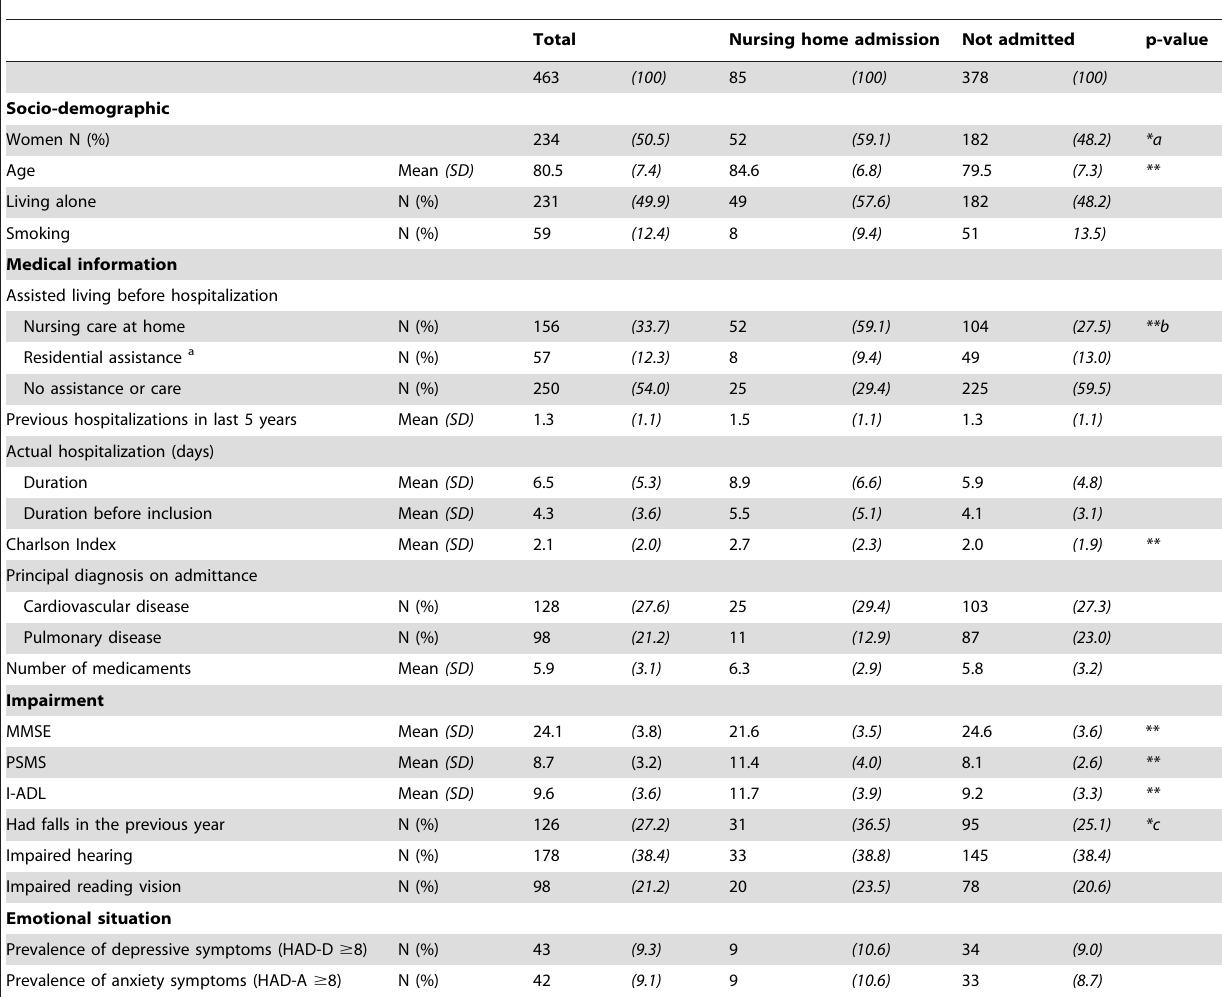
Table 1. Baseline characteristics of study sample, those admitted to nursing home or not within one